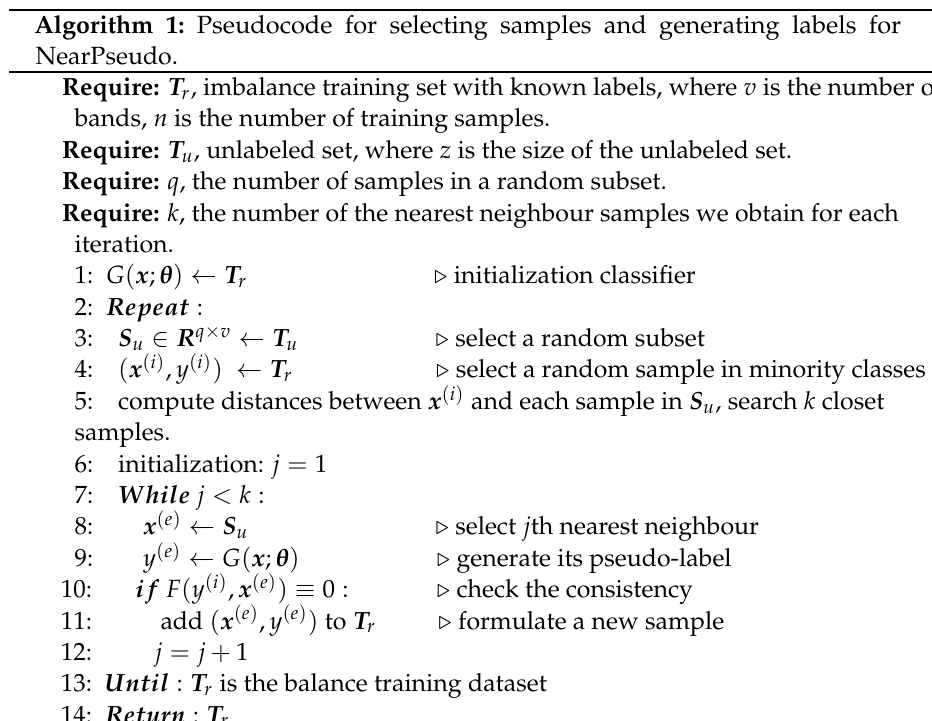
Algorithm 1: Pseudocode for selecting samples and generating labels for